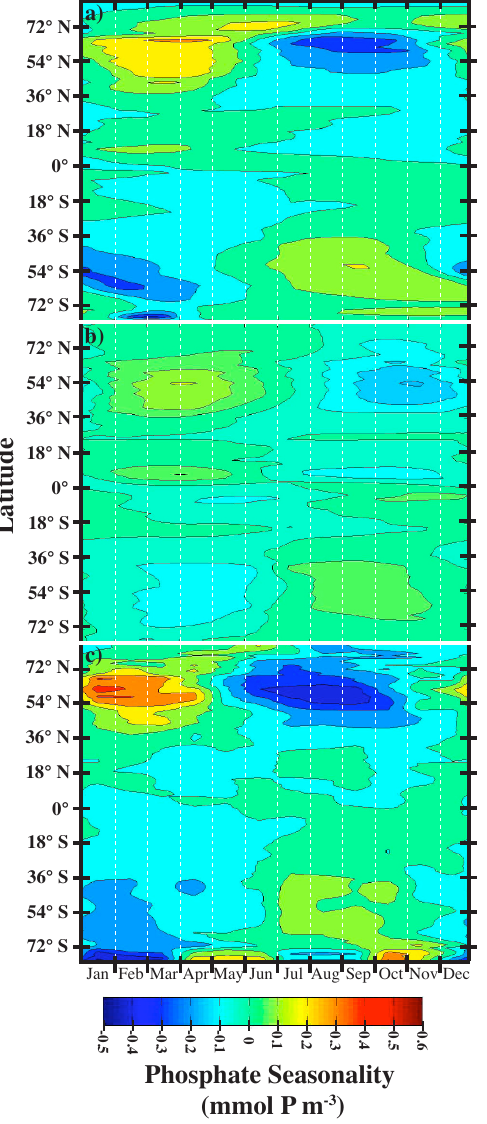
Fig. 12. Hovm¨oller diagrams of the zonally averaged seasonal changes in surface phosphate (monthly climatology minus annual climatology) with the new (a) and old (b) models and from the WOA09 database (c)